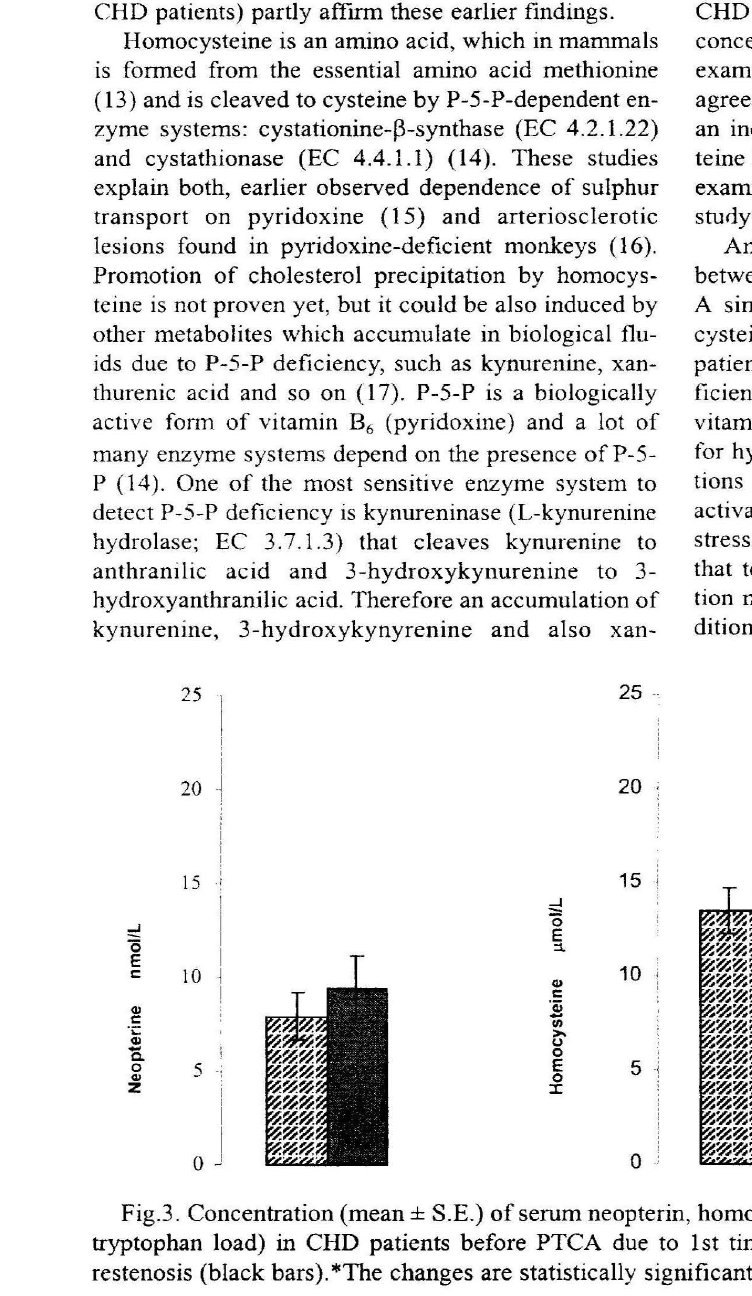
Fig.3. Concentration (mean ± S.E.) of serum neopterin, homocysteine and kynurenine (at 3rd h after 30 mg L tryptophan load) in CHD patients before PTCA due to 1st time stent implantation (hatched bars) and due to restenosis (black bars).*The changes are statistically significant (P <0.05).